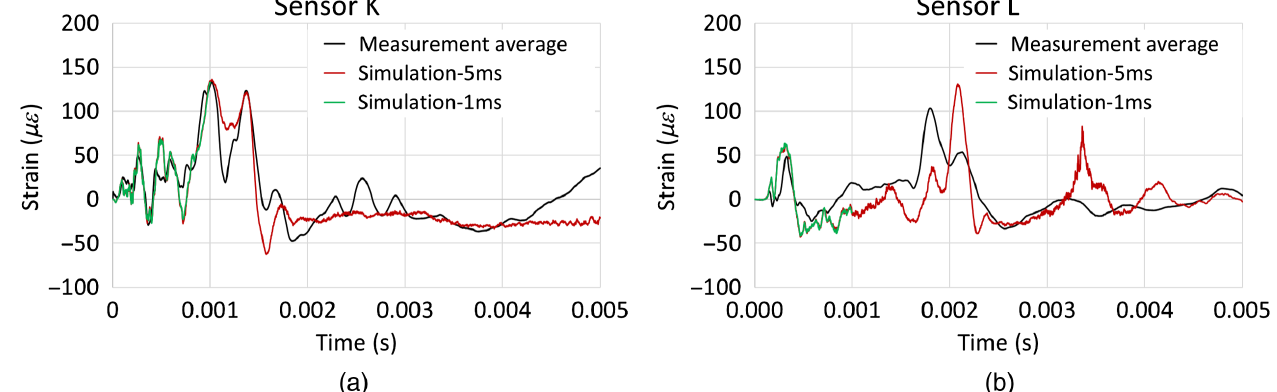
FIG. 21. Strain prediction of sensors K (a) and L (b) with extended simulation time.